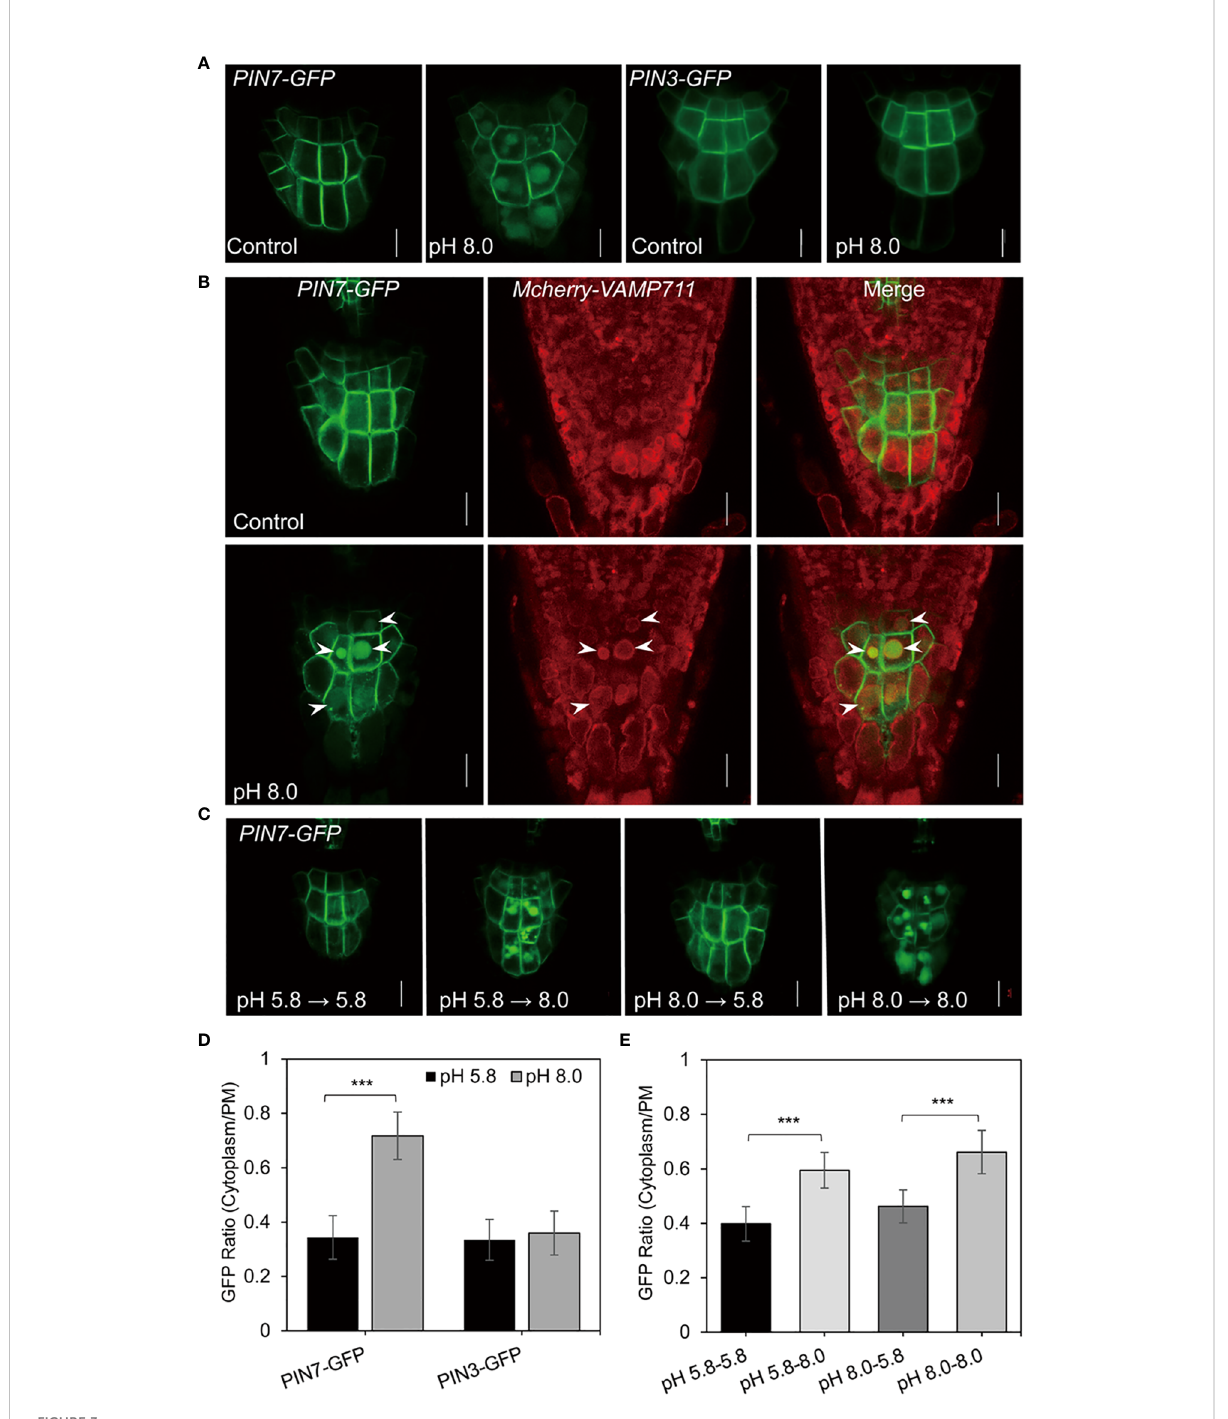
FIGURE 3 PIN7 is transported to the vacuole lumen under alkaline stress. (A) The subcellular localization of PIN3 and PIN7 in columella cells of 6-d-old seedlings under control (pH 5.8) or alkaline (pH 8.0) conditions, respectively. Scale bar, 10 mm. (B) PIN7 is transported to vacuole lumen under alkaline conditions. A crossed line between PIN7 – GFP and the tonoplast marker mCherry-VAMP711 was grown under control (pH 5.8) or alkaline (pH 8.0) conditions for 6 days (n > 10) before imaging. The arrows indicate the co-localized signal between PIN7 – GFP and mCherry- VAMP711- labeled tonoplast. Scale bar, 10 mm. (C) The change of subcellular localization of PIN7 under alkaline conditions is reversible. PIN7 – GFP seedlings were grown under control (pH 5.8) or alkaline (pH 8.0) conditions for 3 days and then transferred to pH 5.8 or pH 8.0 medium plates for another 3 days before imaging. Scale bar, 10 mm. (D, E) Quantitative analysis of the signal ratio between cytoplasm and plasma membrane (PM) in columella cells of PIN7-GFP (D) and PIN3-GFP (E) transgenic seedlings. Statistically signi fi cant differences were determined by using student ’ s t-test (***P <